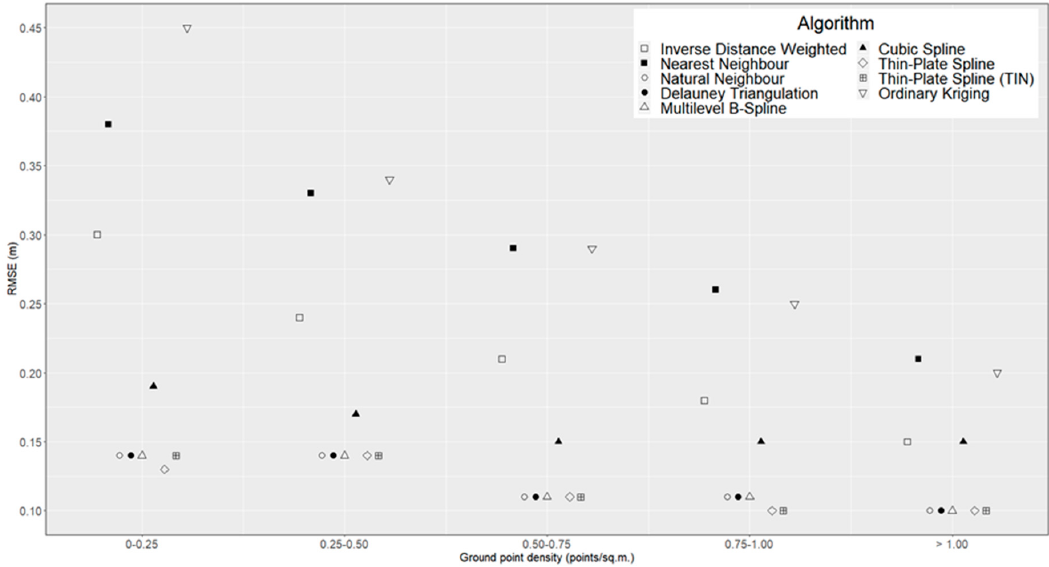
Figure 5. Variation of interpolation accuracy by point density class (model resolution: 0.5 m). For clarity, points are horizontally offset.